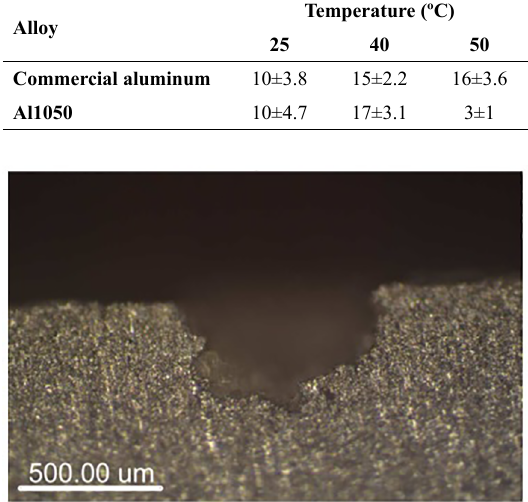
Figure 8. Pit morphology of the Al 1050 alloy specimen: Cross- sectional view of the